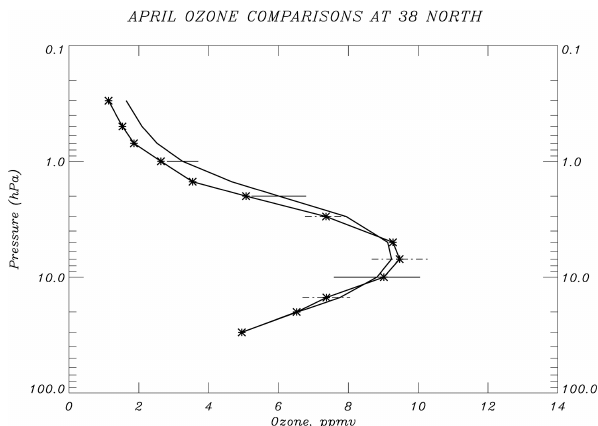
Figure 13. Distribution of the A to D ratios of V6 NO 2 for March 1979. CI is 0.05 (from 0.0 to 0.1) and then 0.1 (from 0.1 to 1.0).